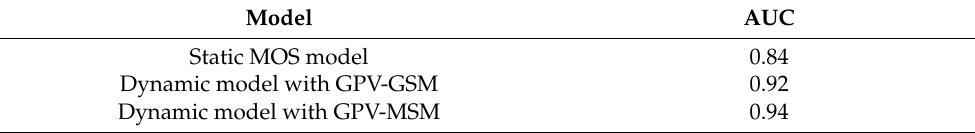
Figure 8. ROC curves of proposed and conventional models. Table 5. Area under the curve (AUC) of proposed model and conventional model.